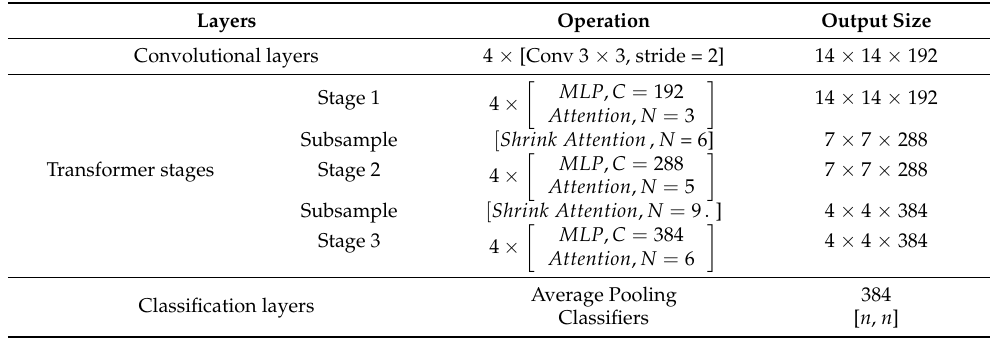
Table 2. Parameters of LeViT-192. Each stage contains pairs of attention and MLP blocks. C is the number of channels in MLP blocks. N is the number of heads in attention blocks. n is the number of the